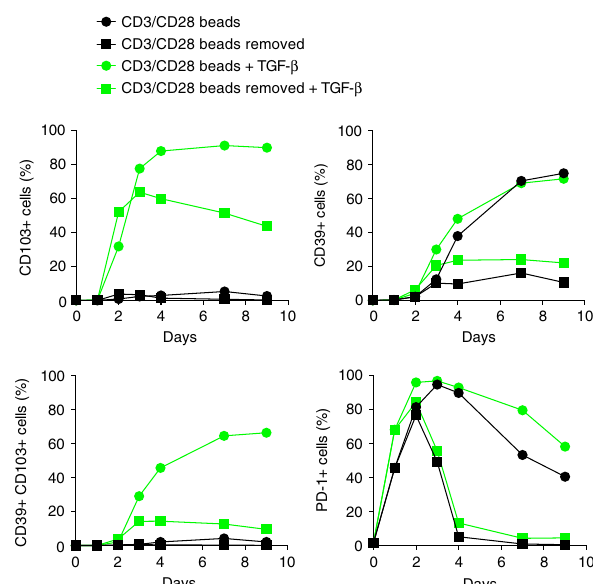
Fig. 4 TGF- β and sustained TCR stimulation are required for CD103 and CD39 upregulation on CD8 T cells. Kinetics of CD39, CD103, and PD-1 expression on sorted naive CD8 T cells from peripheral blood after in vitro activation. Cells were stimulated with CD3/CD28-coated beads at a bead: T-cell ratio of 1:2 in the presence or absence of TGF- β 1 (2 ng/ml), and expression of CD39, CD103, and PD-1 was analyzed by fl ow cytometry at the indicated time points. Data are from one representative healthy